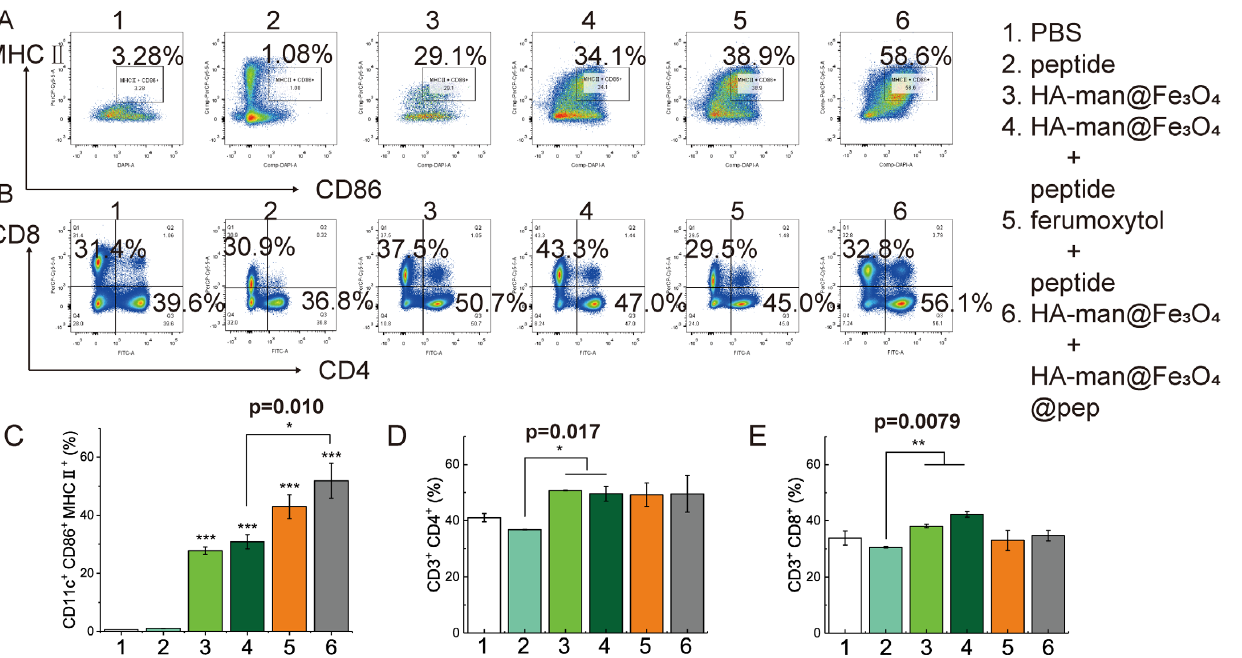
Figure 8. Flow cytometry analysis of sentinel lymph node tissue 24 h posttreatment. ( A , C ) Expression of maturation markers in DCs; ( B , D , E ) expression of CD8 and CD4 in T cells. Error bars indicate at least three independent experiments. p -value has been calculated by one-way ANOVA test. * p < 0.05, ** p < 0.01, and *** p < 0.001.